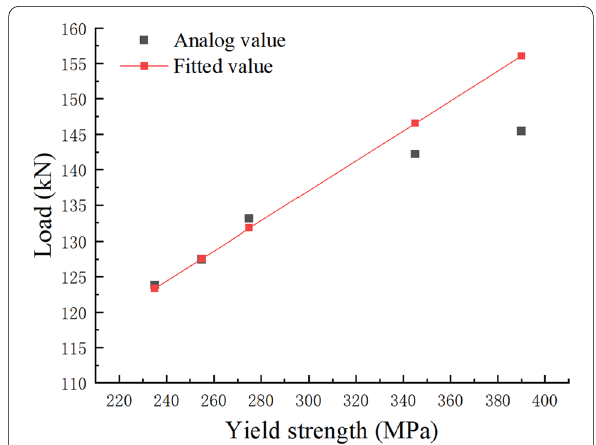
Fig. 20 Effect of yield strength on the strength of the connector.